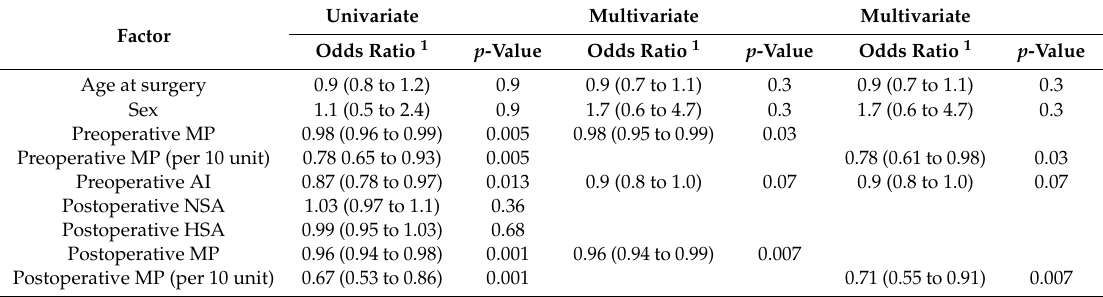
Table 4. Predictors of surgical success using generalized estimating equation.